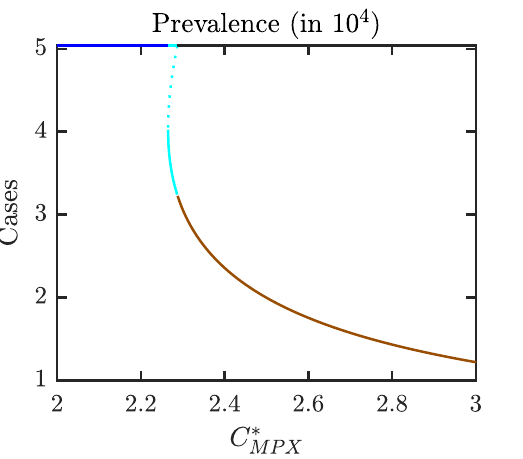
Fig 17. MPX prevalence in a population that uses optimal voluntary vaccination rates; β = 0.18 and other parameters as specified in Table 1. The lines are color coded corresponding to the regions shown in Fig 10 which shows a diagram for Nash equilibria as e and C � vary. Blue: 0 is the only NE and it is CSNE. Brown: positive ψ NE is MPX the only NE and it is CSNE. Light blue: three NEs, 0 and the larger NE are CSNE.